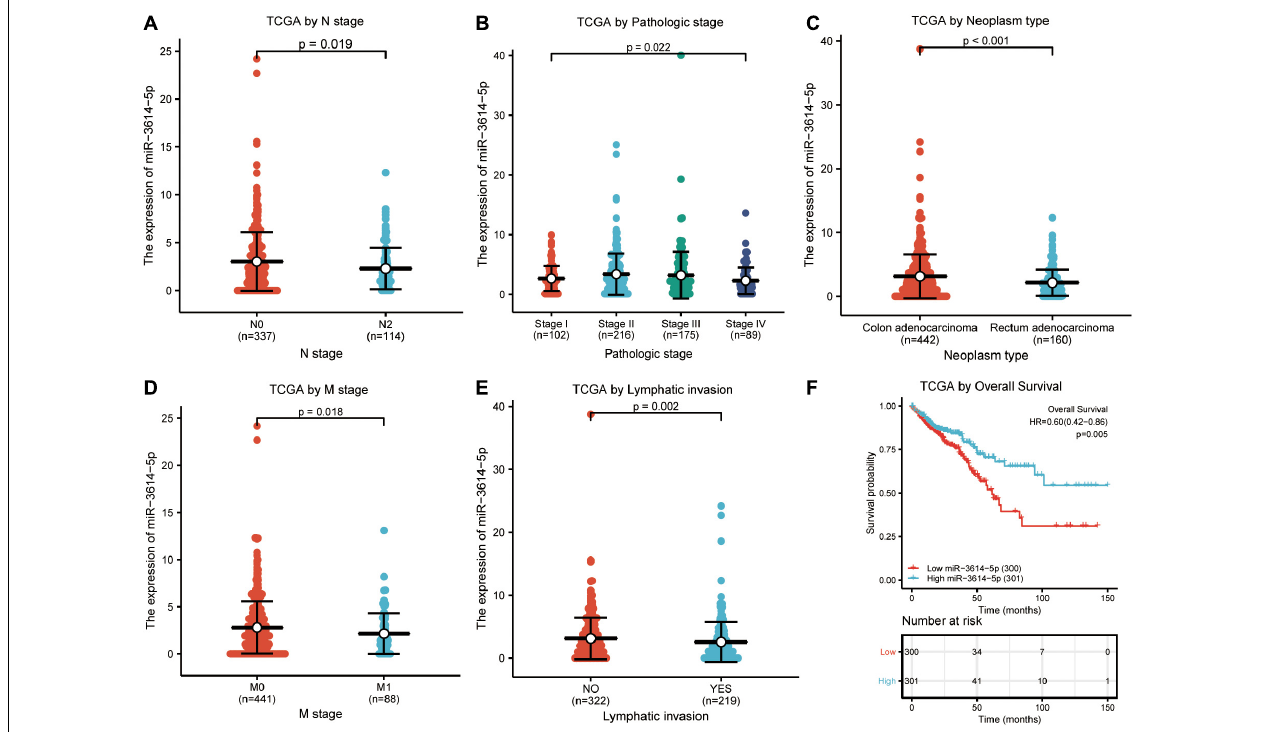
FIGURE 2 | Correlation analysis between miR-3614-5p expression and clinicopathological factors. (A) N stage. (B) Pathologic stage. (C) Neoplasm type. (D) M stage. (E) Lymphatic invasion. (F) Effect of miR-3614-5p expression on OS of CRC patients in TCGA cohort. TCGA, The Cancer Genome Atlas; OS, overall survival; CRC, colorectal